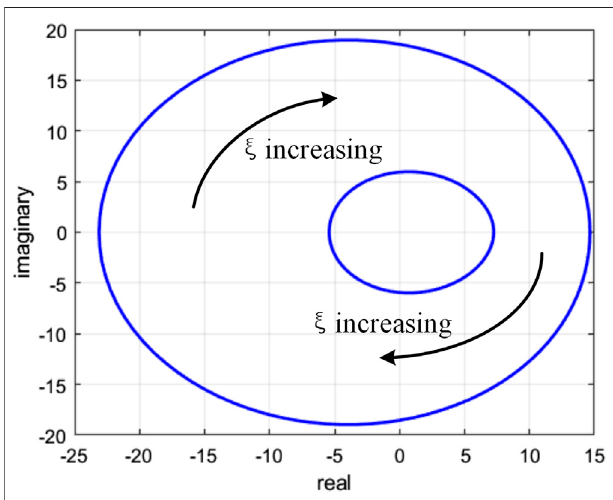
FIGURE 7 | Dominant root loci of the case with k i 1 (cid:1) 12, k i 2 (cid:1) 10.